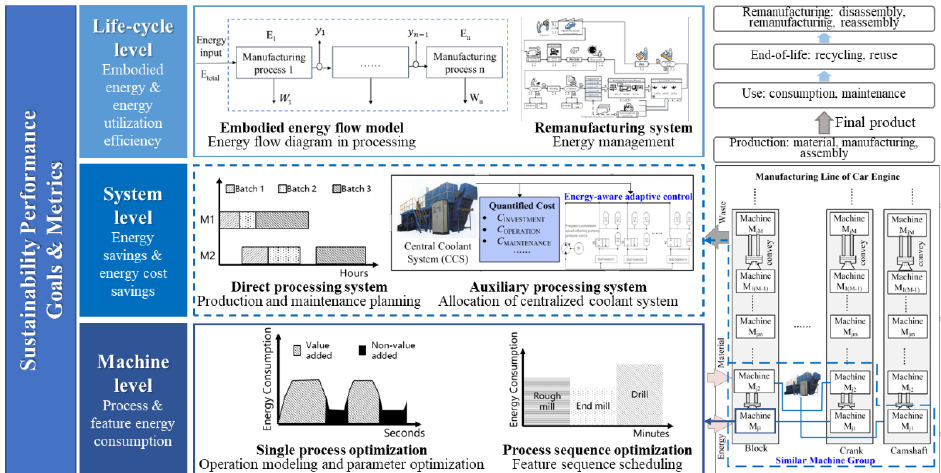
Figure 1. Multi-level efficiency analysis and innovations with different decision